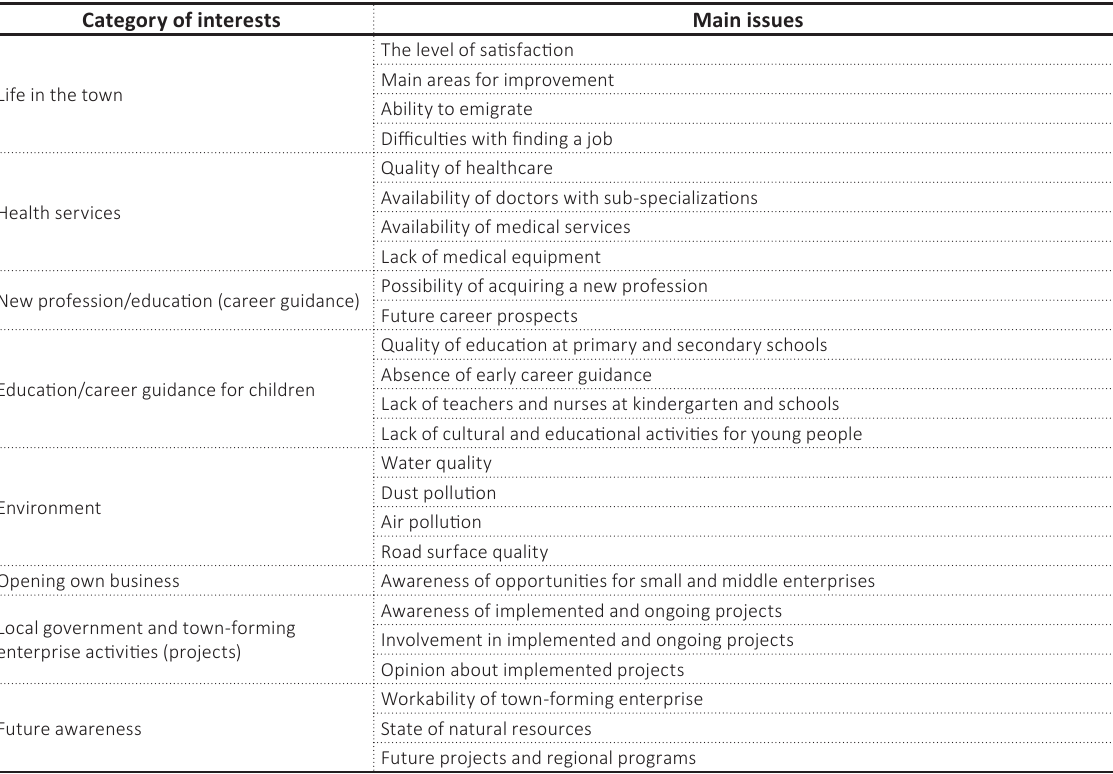
Table 1. Local communities’ interests in regional development